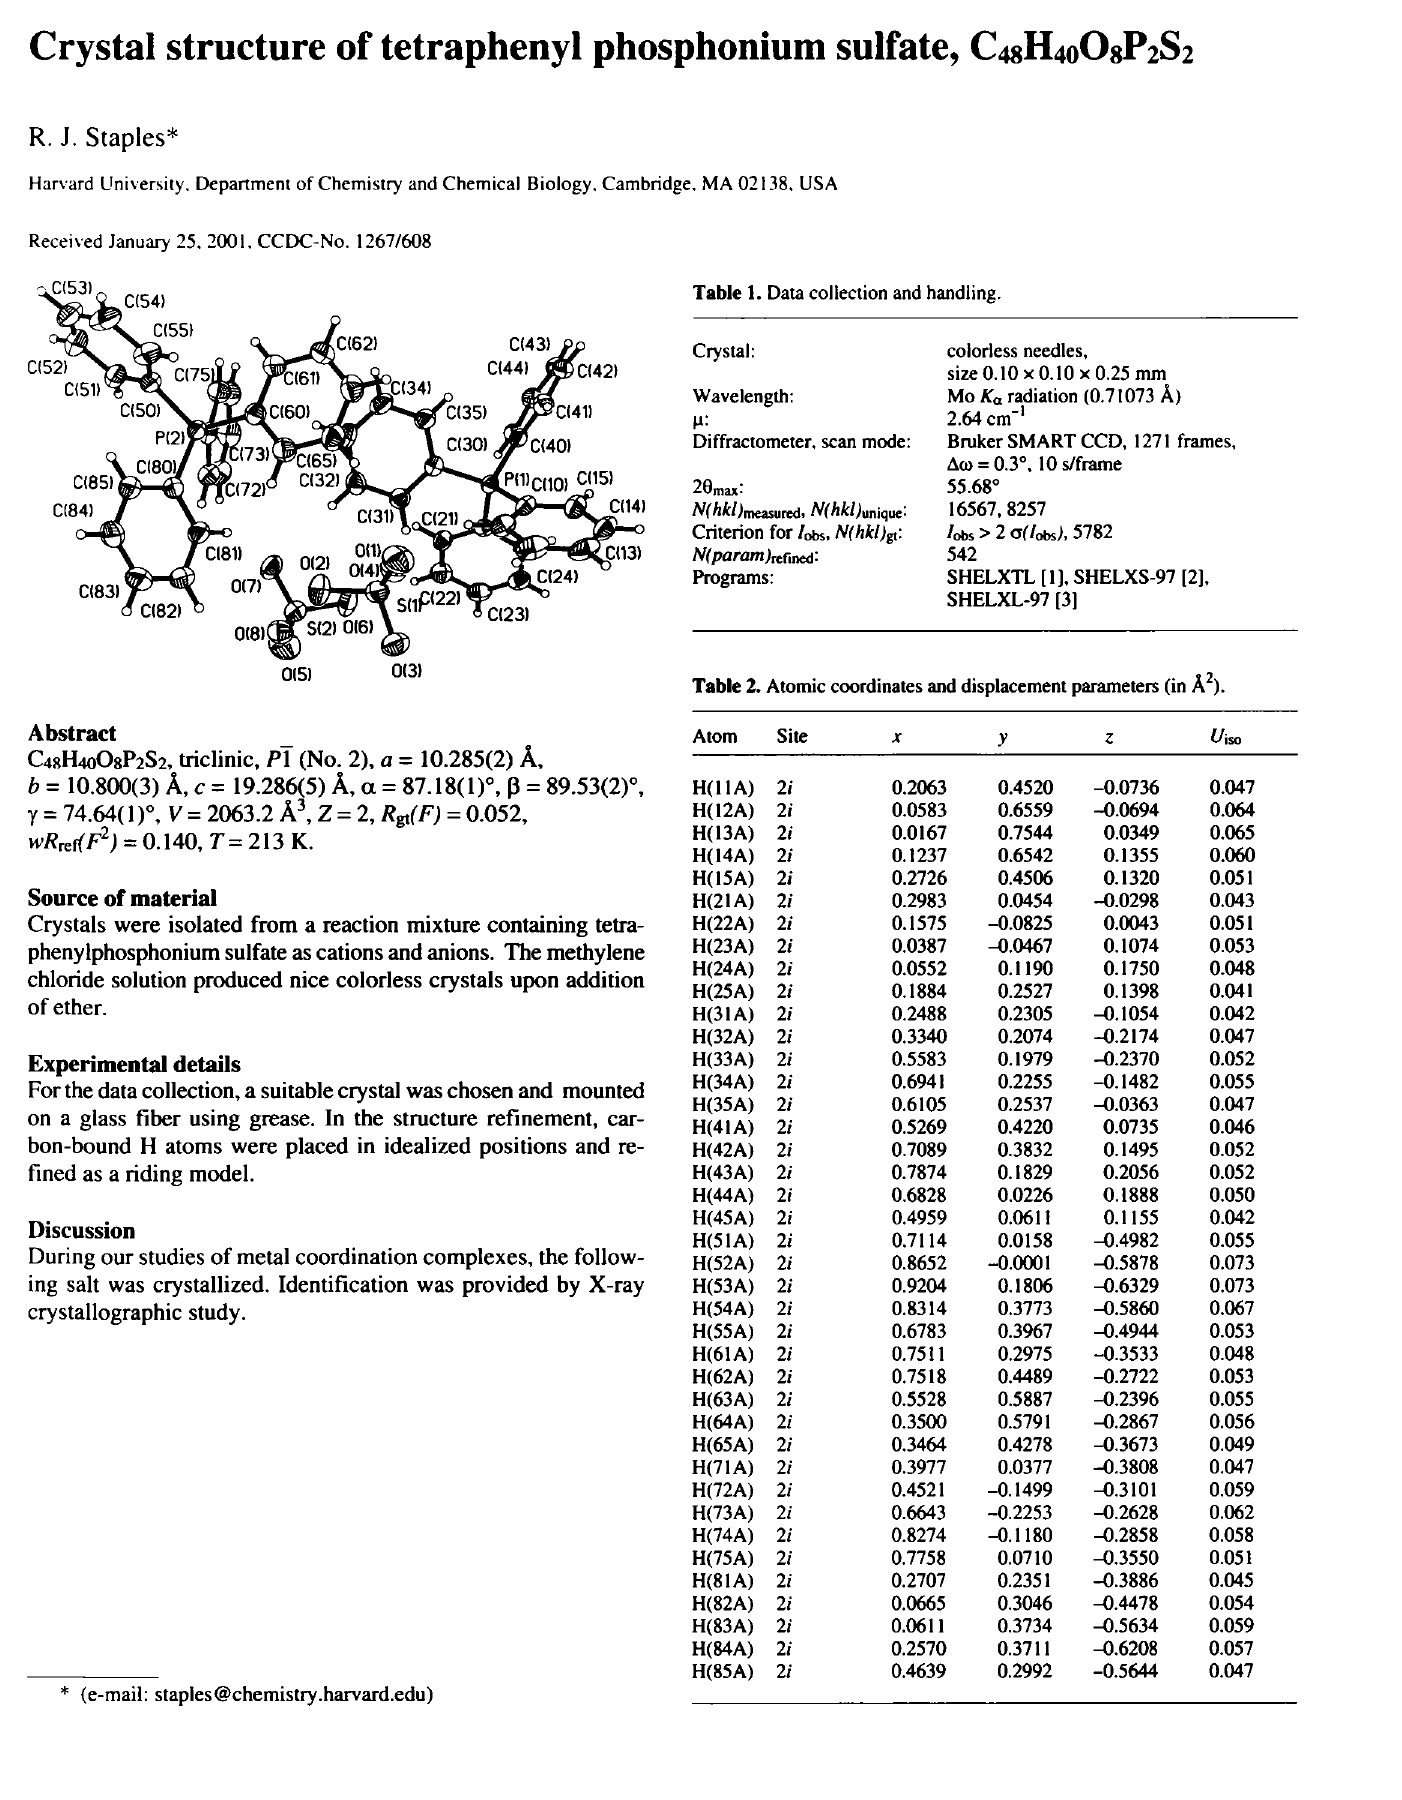
Table 1. Data collection and handling.